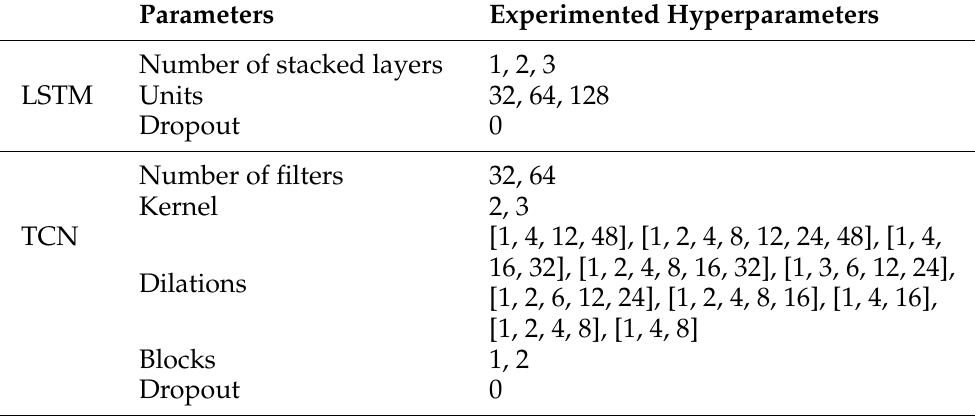
Table 3. Hyperparameters experimented with for